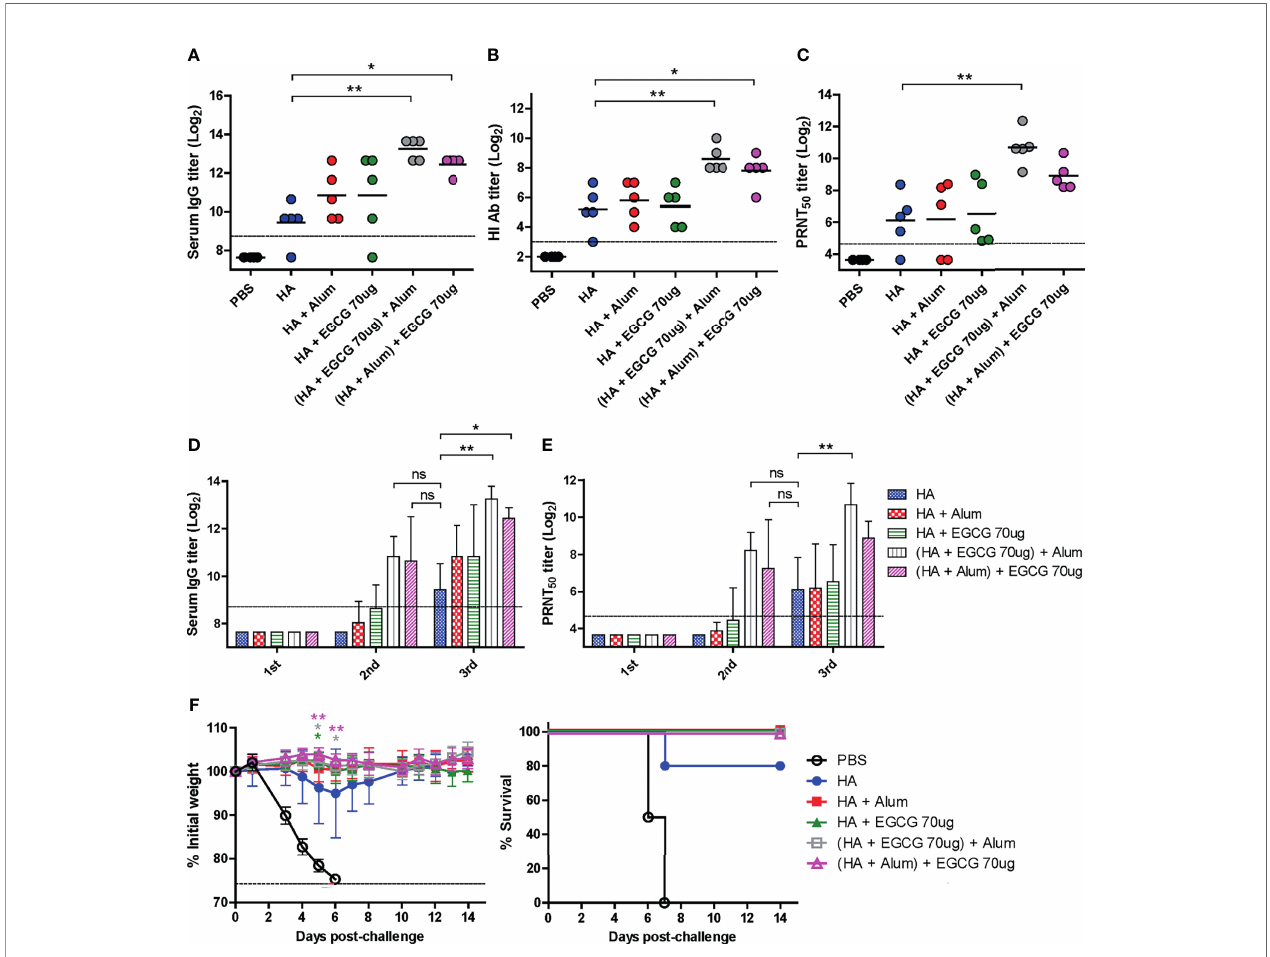
FIGURE 6 | Synergistic effect of EGCG and alum. PBS or 7 µg of HA antigens with or without adjuvant (30 m L of alum, 70 m g of EGCG, or both alum and EGCG) were injected into mice thrice every 2 weeks. The overall experimental schedule was the same as presented in Figure 3A . (A – C) ELISA, HI assay, and PRNT were conducted to verify the synergistic relationship between EGCG and alum on vaccine immunogenicity. Data were log-transformed and expressed as means (horizontal lines) and scatter plots. (A) IgG antibody response to in fl uenza PR8 virus. The antibody titer of each sample was expressed as the endpoint dilution with an absorbance value 2× greater than that of the PBS control group. The detection limit (dashed line) was 400. (B, C) Neutralizing antibody responses to in fl uenza PR8 virus. HI antibody titers (B) and PRNT 50 titers (C) against the PR8 virus. The detection limits of the HI assay and PRNT (dashed lines) were 8 and 25, respectively. (D) IgG antibody response to in fl uenza PR8 virus depending on the number of vaccine doses. Data were log-transformed and expressed as means (bar graphs) and standard deviations (error bars). The detection limit (dashed line) was 400. (E) Neutralizing antibody responses to in fl uenza PR8 virus depending on the number of vaccine doses. Data were log-transformed and expressed as means (bar graphs) and standard deviations (error bars). The detection limit (dashed line) was 25. (F) Protective ef fi cacy against in fl uenza PR8 virus. Mice were challenged with 4 × 10 3 PFU (4 MLD 50 ) of in fl uenza PR8 virus after the last vaccination. Dashed line indicates humane endpoint which means losing 25% weight loss. Mice that lost >25% body weight were euthanized. Data of the changes in weight ( F , left panel) are shown as means (points) and standard deviations (error bars). One-way ANOVA followed by Tukey ’ s multiple comparison test was conducted to compare three or more groups. Repeated measures two-way ANOVA followed by Bonferroni ’ s post-test was used to analyze weight changes for different mouse groups over time. Each group was compared with the group given the non-adjuvanted HA (** P < 0.01; * P < 0.05. ns, not signi fi